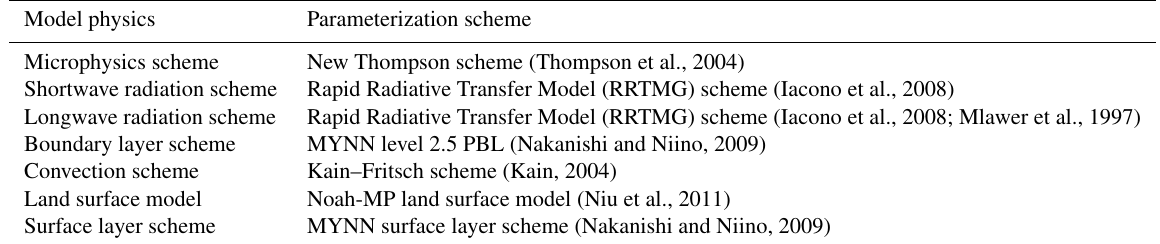
Table 1. Applied parameterizations of the simulations from Jach et al.